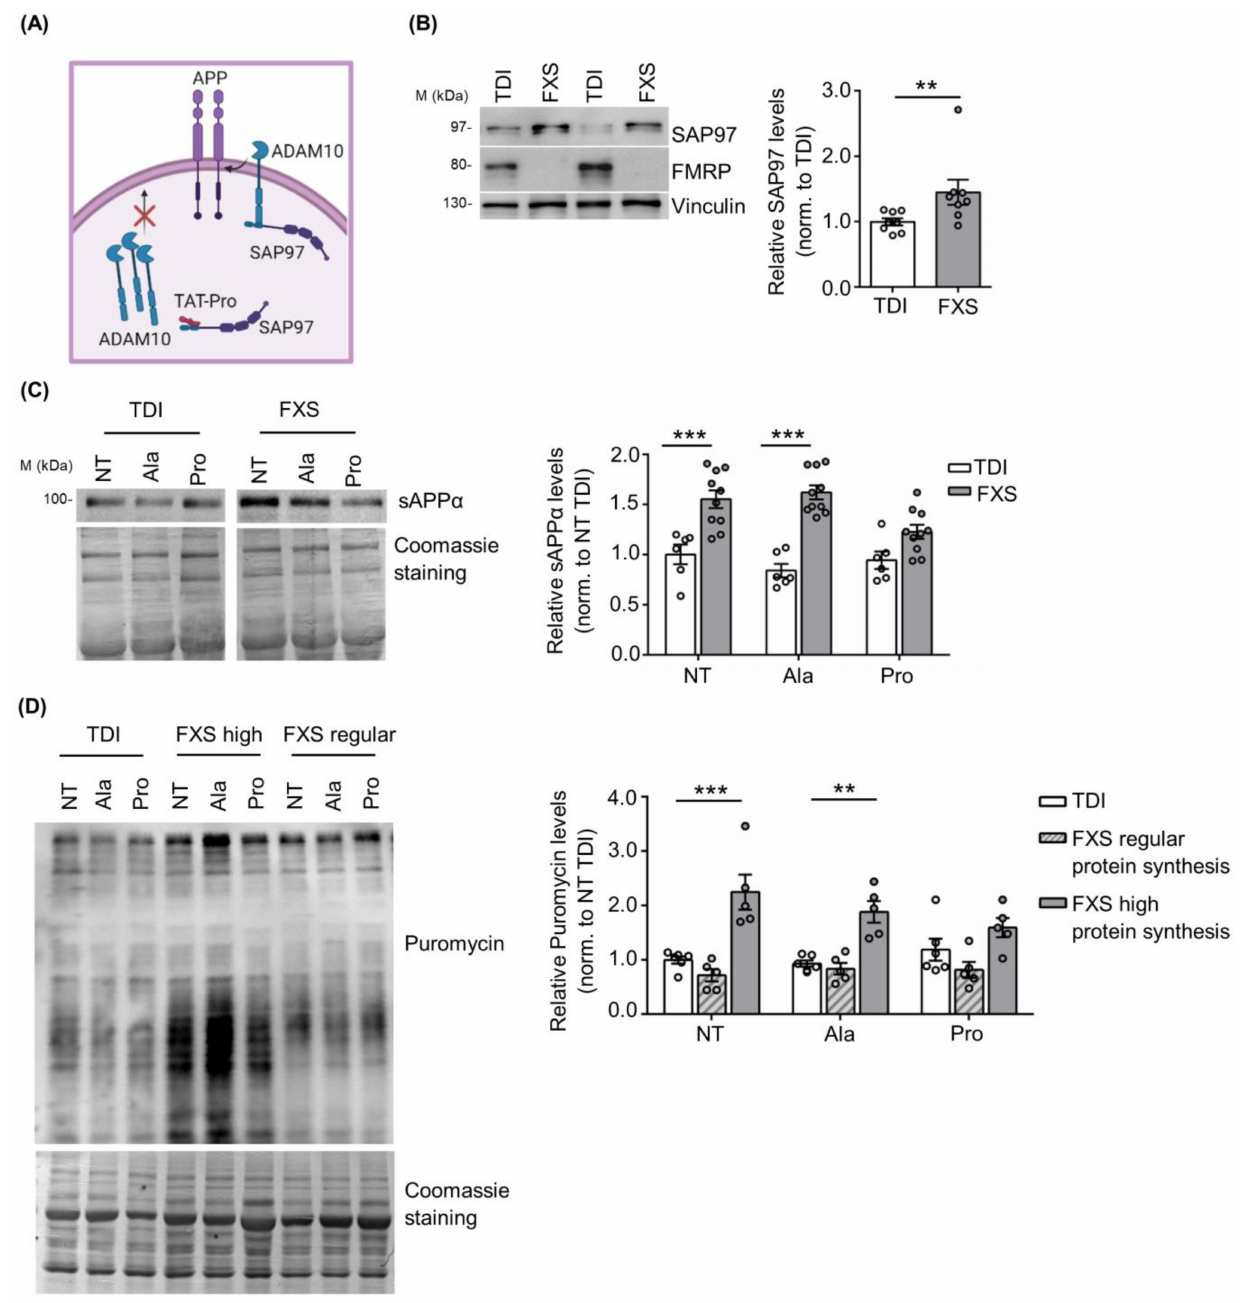
Figure 3. Modulation of ADAM10 in human TDI and FXS fibroblasts. ( A ) Schematic representation of the mechanism of action of the TAT-Pro peptide (image created in BioRender.com). ( B ) Left, representative Western blot showing SAP97 expression in TDI and FXS fibroblasts. Right, the bar plot shows the quantification of SAP97 levels in TDI and FXS fibroblasts (TDI n = 8; FXS n = 8). Error bars represent the SEM (** p < 0.01, Mann–Whitney test). ( C ) Left, representative Western blots showing the levels of sAPP α in non-treated fibroblasts (NT), treated with the control peptide (Ala) or with the specific peptide (Pro). Right, the bar plots show the quantification of sAPP α normalized to Coomassie staining (TDI n = 6, FXS n = 10). Error bars represent the SEM (Two-way ANOVA analysis: genotype effect F (1, 42) = 61.97 *** p < 0.001; treatment effect F(2, 42) = 2.866 p > 0.05; interaction effect F(2, 42) = 4.422) (*** p < 0.001 NT TDI vs. NT FXS; *** p < 0.001 TAT-Ala TDI vs. TAT-Ala FXS,